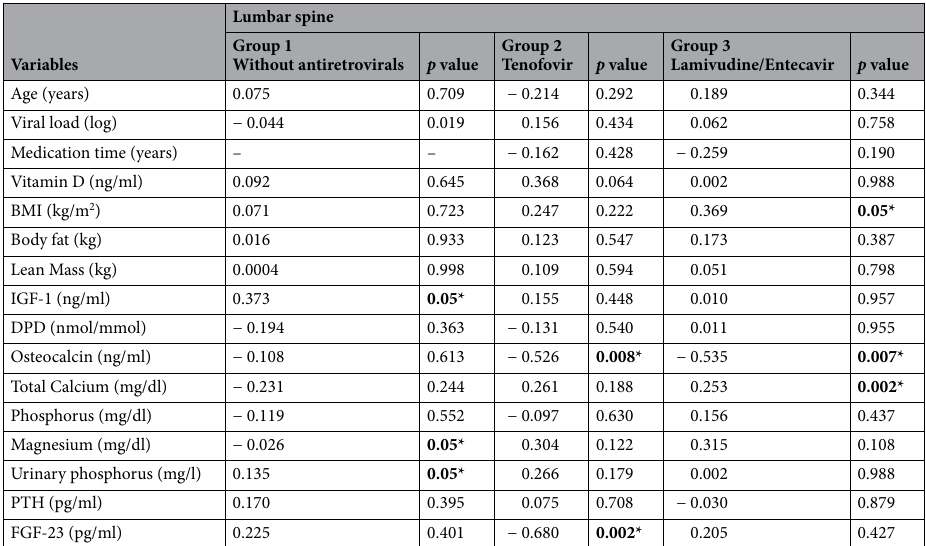
Table 3. Correlation by groups between biochemical markers, body composition and viral parameters with bone mineral density of the lumbar spine in patients with chronic hepatitis B virus infection in use or not of antiretrovirals. Parameters with statistical differences are given in bold. Pearson correlation, significance level p ≤ 0.05 indicated by *. DPD, deoxypyridinoline; PTH, parathormone; IGF-1, insulin-like growth factor-1; FGF-23, fibroblast growth factor 23; BMI, body mass index. FGF-23 n = 16–17 per group.